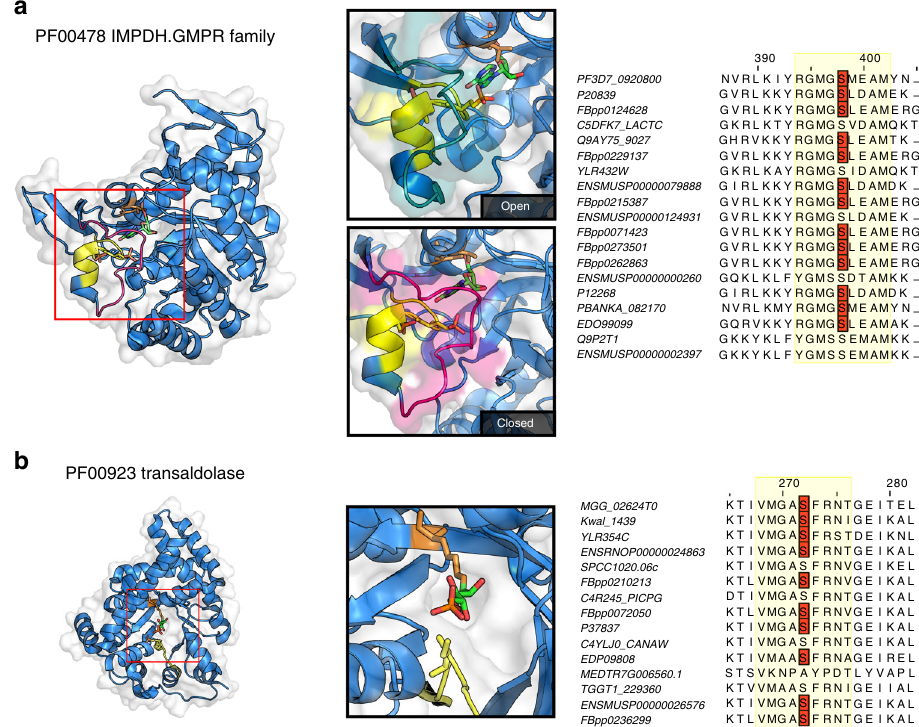
Fig. 5 Hotspot regions near catalytic residues that are distal in protein sequence. a The IMPDH hotspot region is represented in yellow segment. In the insets, the loop near the hotspot region is shown changing from an open conformation (blue volumes) to closed conformation (magenta volumes). A serine residue within the hotspot region (yellow sticks) points to substrate binding pocket and is often found phosphorylated across species (see alignment). b The transaldolase hotspot region is shown in yellow. In the structural inset a serine within the hotspot region (yellow sticks) is found just at the entrance of the substrate cavity. The identi fi ed phosphorylation sites contributing to the identi fi cation of the hotspot region are shown in the alignments in